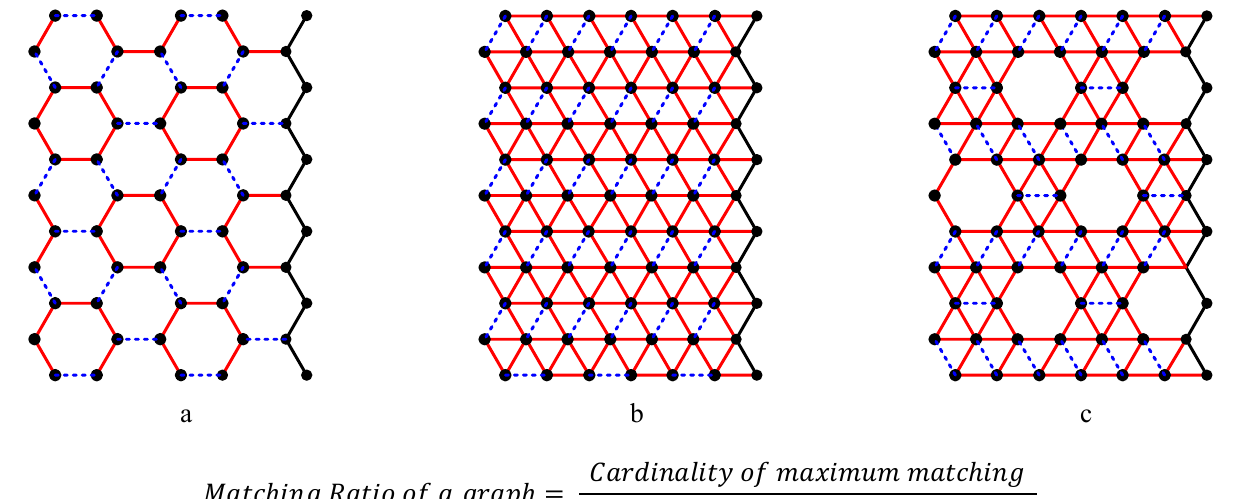
Figure 5. All three nanotubes have perfect matching. The edges of blue dotted lines form a perfect